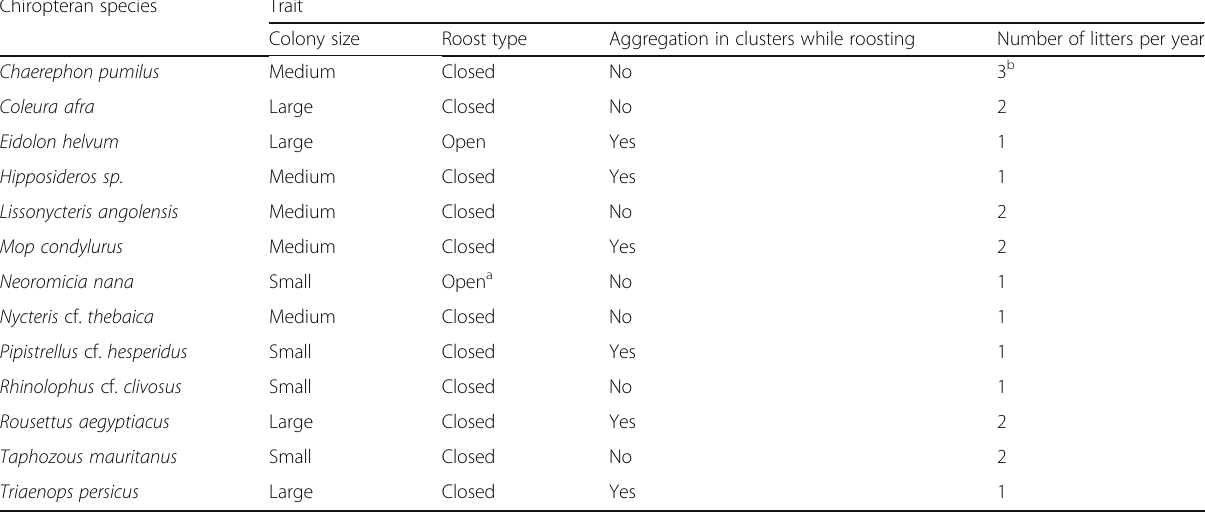
Table 1 Summary of traits by sampled chiropteran species Chiropteran species